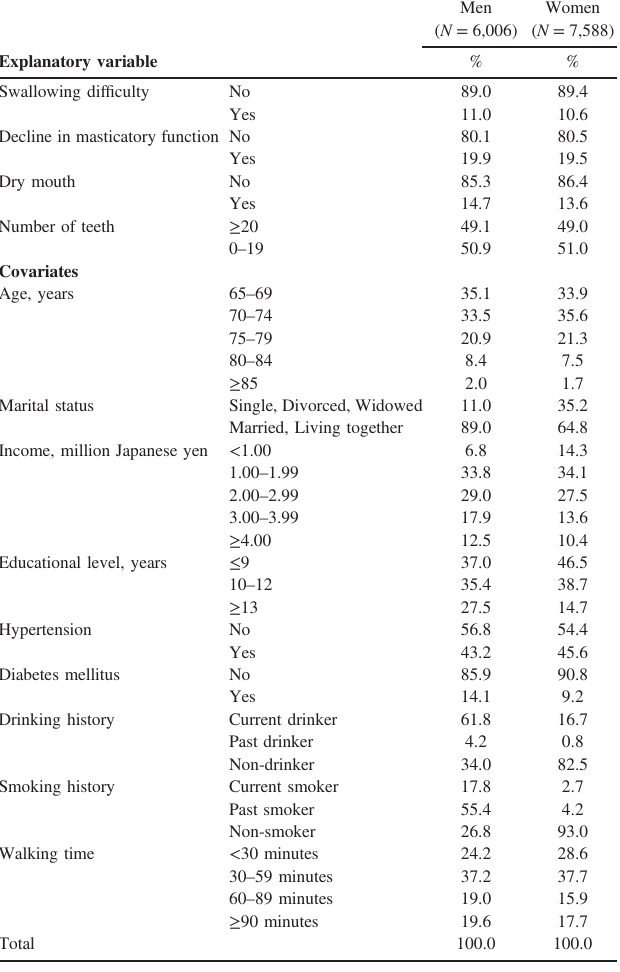
Table 2. The cross-tabulation of the onset of subjective cognitive complaint in 2016 by oral health status in 2010 and changes in 2010 – 2016 ( N = 13,594) Men